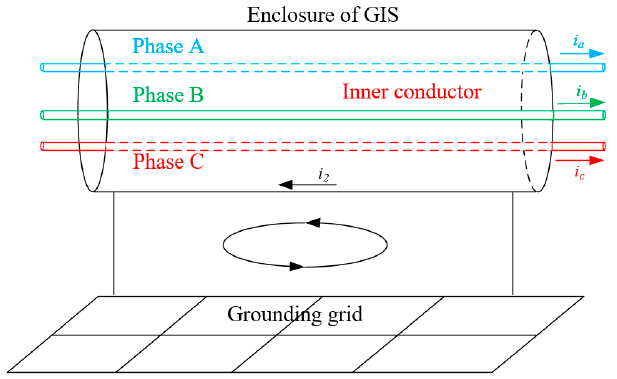
Figure 4. Circulating current of three phase insulated type GIS.